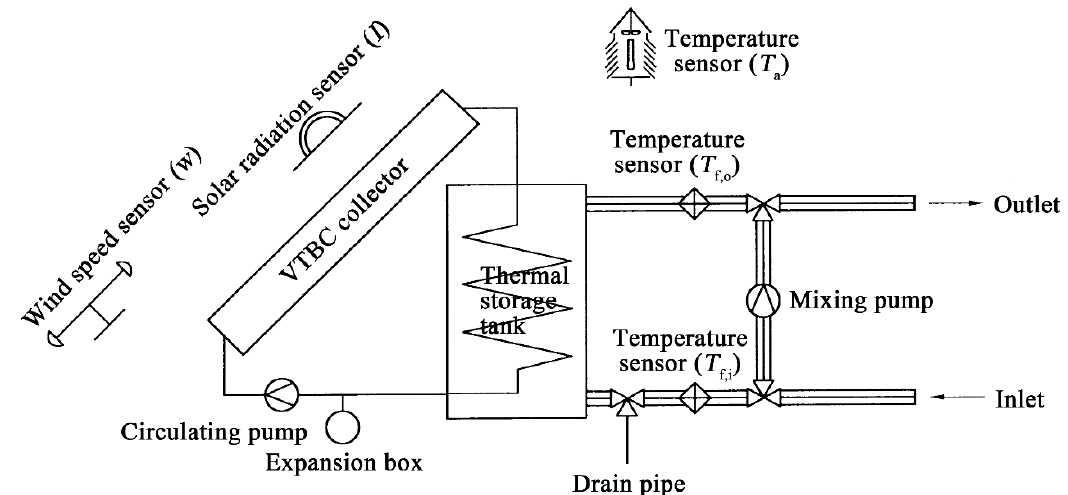
Figure 11. System diagram for the tested VTBC solar collector. Table 2. Input parameters of the reference collector model.